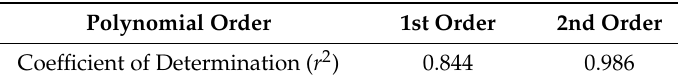
Table 5. Results from the regression.